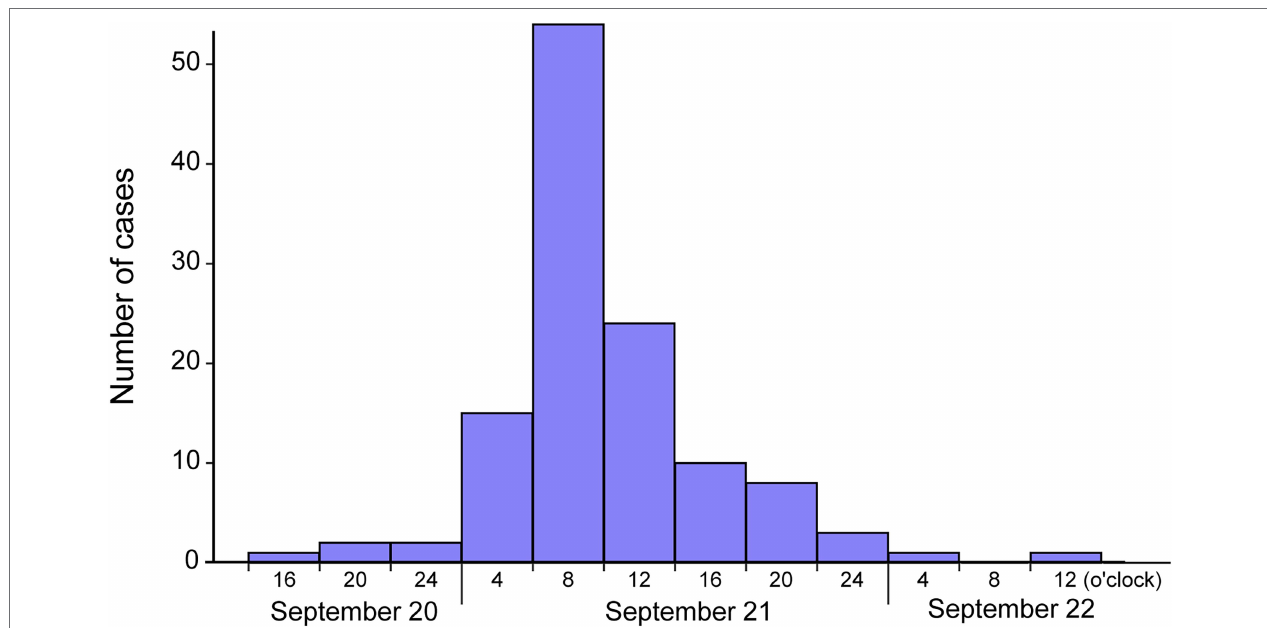
FIGURE 2 | Epidemic curve of the Salmonella Enteritidis outbreak associated with the consumption of egg sandwiches in a nursery school, Shenzhen and Dongguan, Guangdong province,